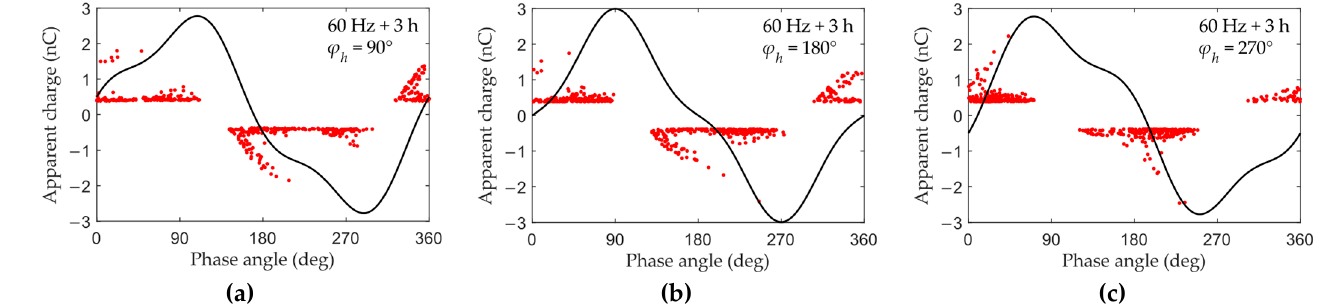
Figure 16. PRPD patterns obtained in the simulations for the cases wherein voltages distorted by the 3rd harmonic component was applied with THD = 20% and ϕ h = : ( a ) 90 ◦ ; ( b ) 180 ◦ ; ( c ) 270 ◦ . Regarding the effects of harmonic components on the PRPD patterns, Section